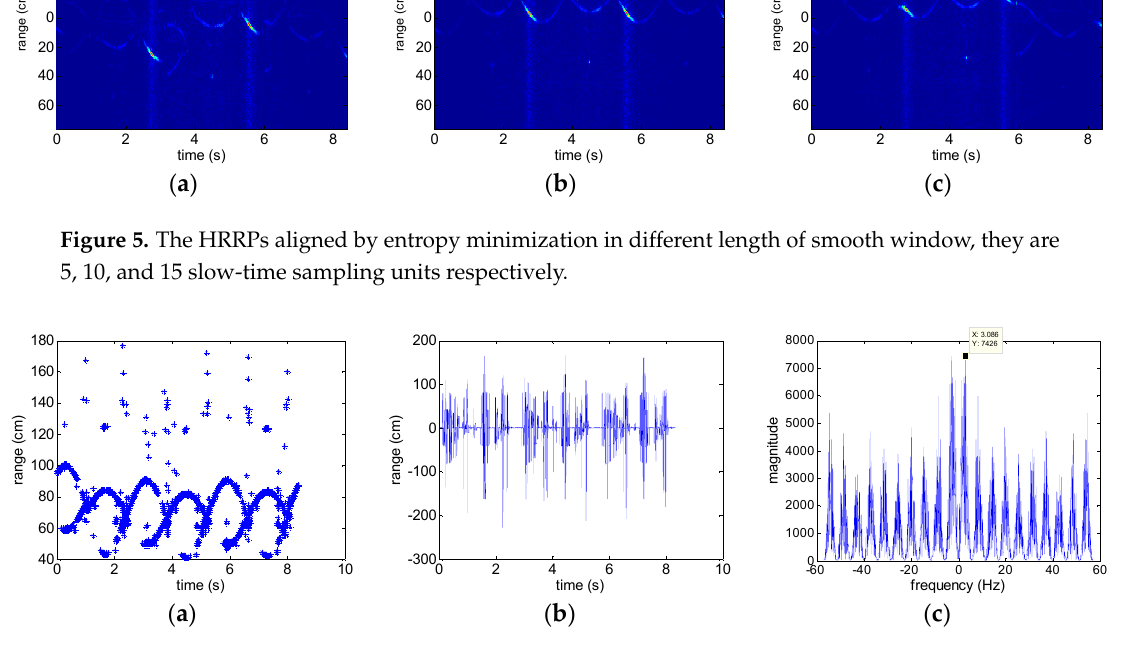
Figure 6. Results motivated by method proposed in [6]. ( a ) instantaneous range of the scattering center with largest energy; ( b ) high-order difference sequence with optimal spectral concentration measure; ( c ) the spectrum of high-order difference sequence.